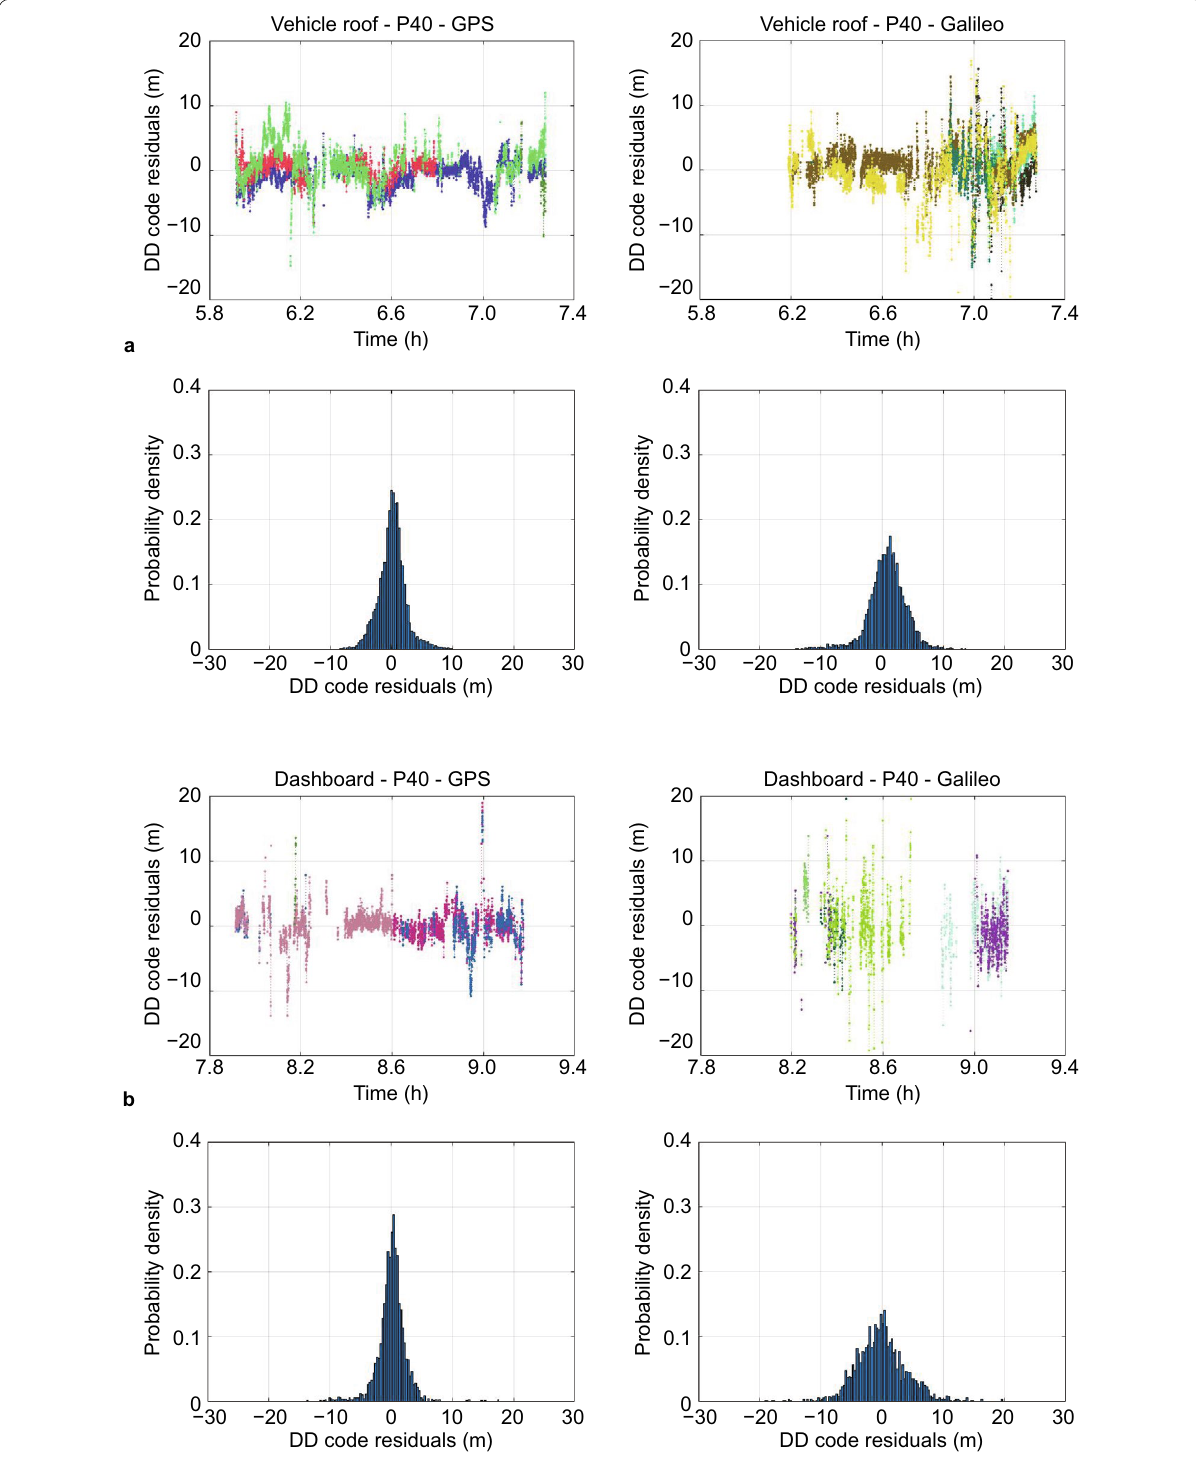
Fig. 6 Time series and probability density distribution of double-differenced (DD) GPS/Galileo L5/E5a code residuals for the P40 smartphone in a the vehicle-roof mode and b the dashboard